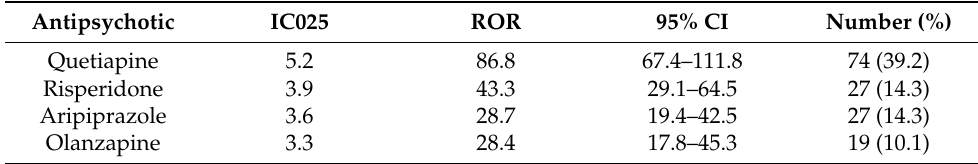
Table 3. Disproportionality analysis for main antipsychotics involved in reports of withdrawal in patients aged between 0 days and 23 months, ranked by ROR.